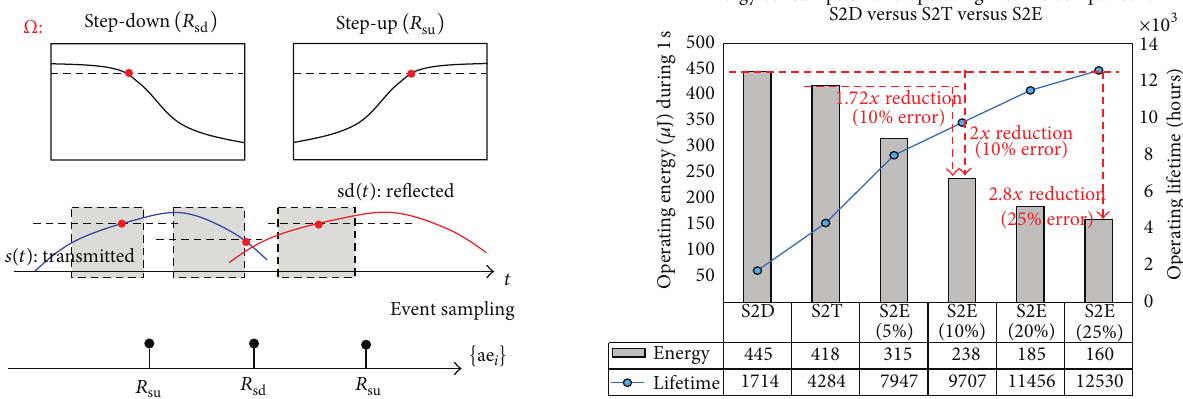
Figure 11: Experimental